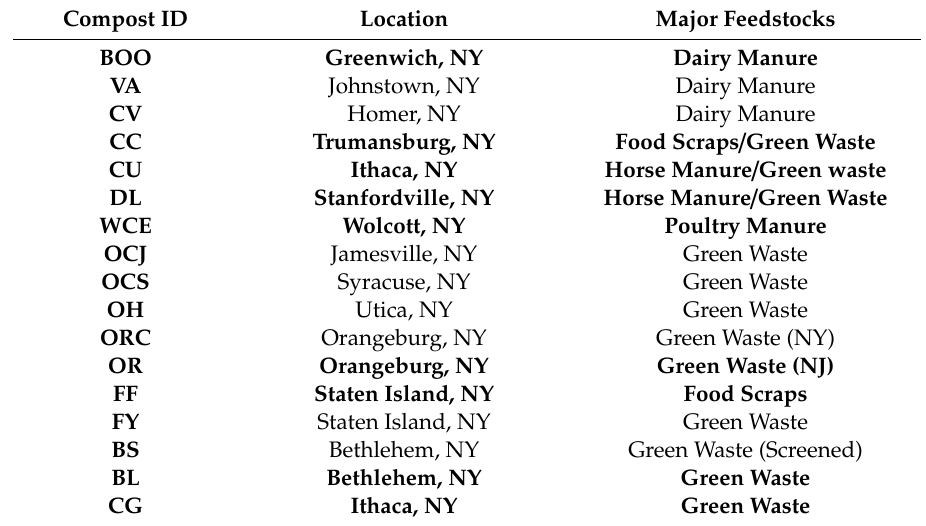
Table 1. Seventeen composts collected from around New York State. Those in bold were selected for further